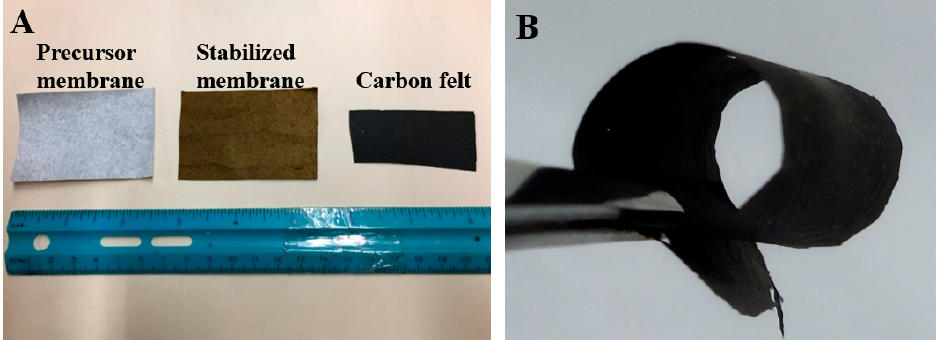
Figure 2. ( A ) A photo showing the precursor PAN/biochar nanofibrous membrane ( left ), stabilized membrane ( middle ), and carbon nanofibrous felt ( right ). ( B ) A photo showing the flexibility of the resulting carbon nanofibrous felt.